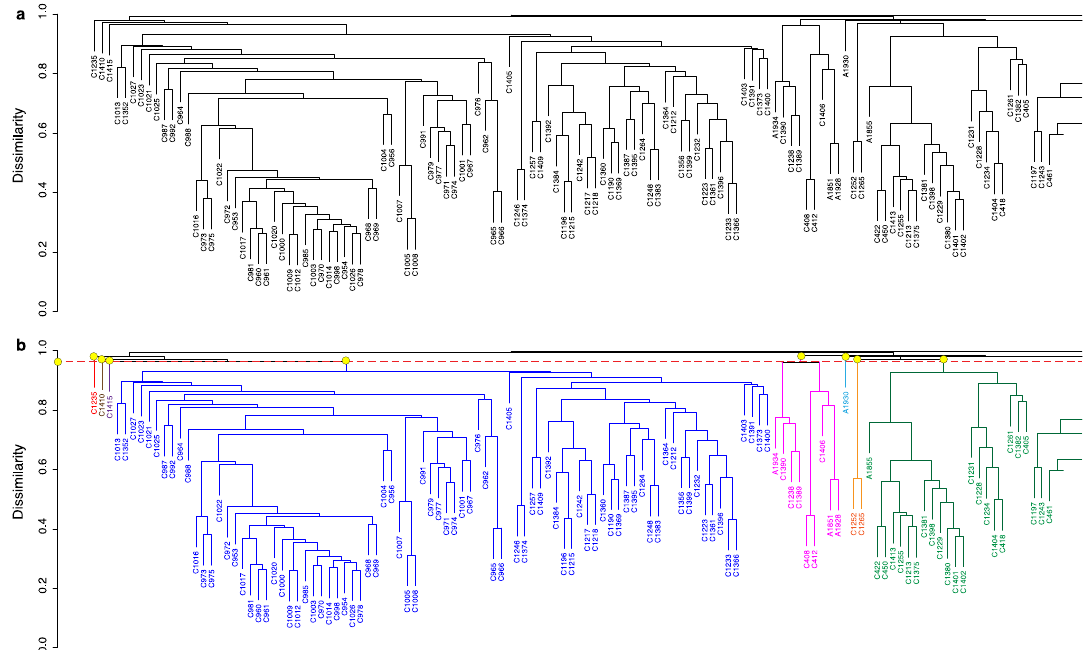
Figure 2. ( a ) Partial dendrogram generated from an HCA of all 1046 samples. The scale on the left denotes dissimilarity i.e., the closer to the bottom a pair of samples are, the more similar they are to each other. Only a small subset of the figure is shown for clarity; the original complete dendrogram may be found in the Supplementary Information as Figures S1 (linear display) and S3 (circular display). ( b ) Arbitrary dissimilarity cutoff choice of 0.95 results in eight different groups being formed. The groups have been colored accordingly. The eight groups have been colored as red, brown, grey, blue, magenta, teal, orange, and green. The yellow dots indicate the point at which the tree branch diverges to form each respective colored group of samples.